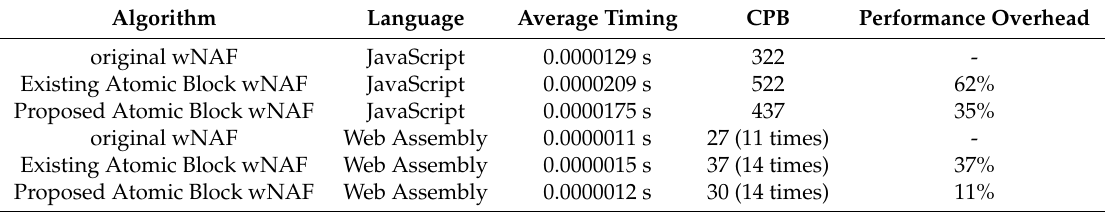
Table 15. wNAF algorithm performance in Microsoft Edge ( CPB : Cycle Per Byte), ( w = 4).